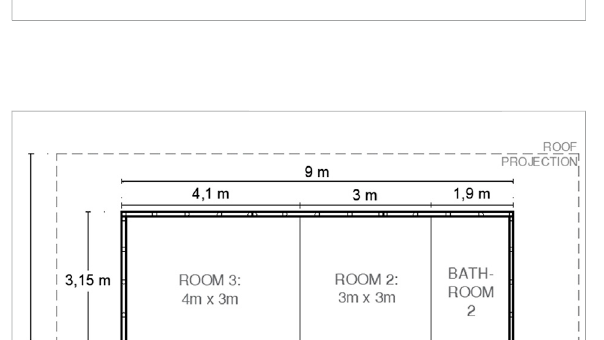
FIGURE 5 Ground Floor of the proposed model.